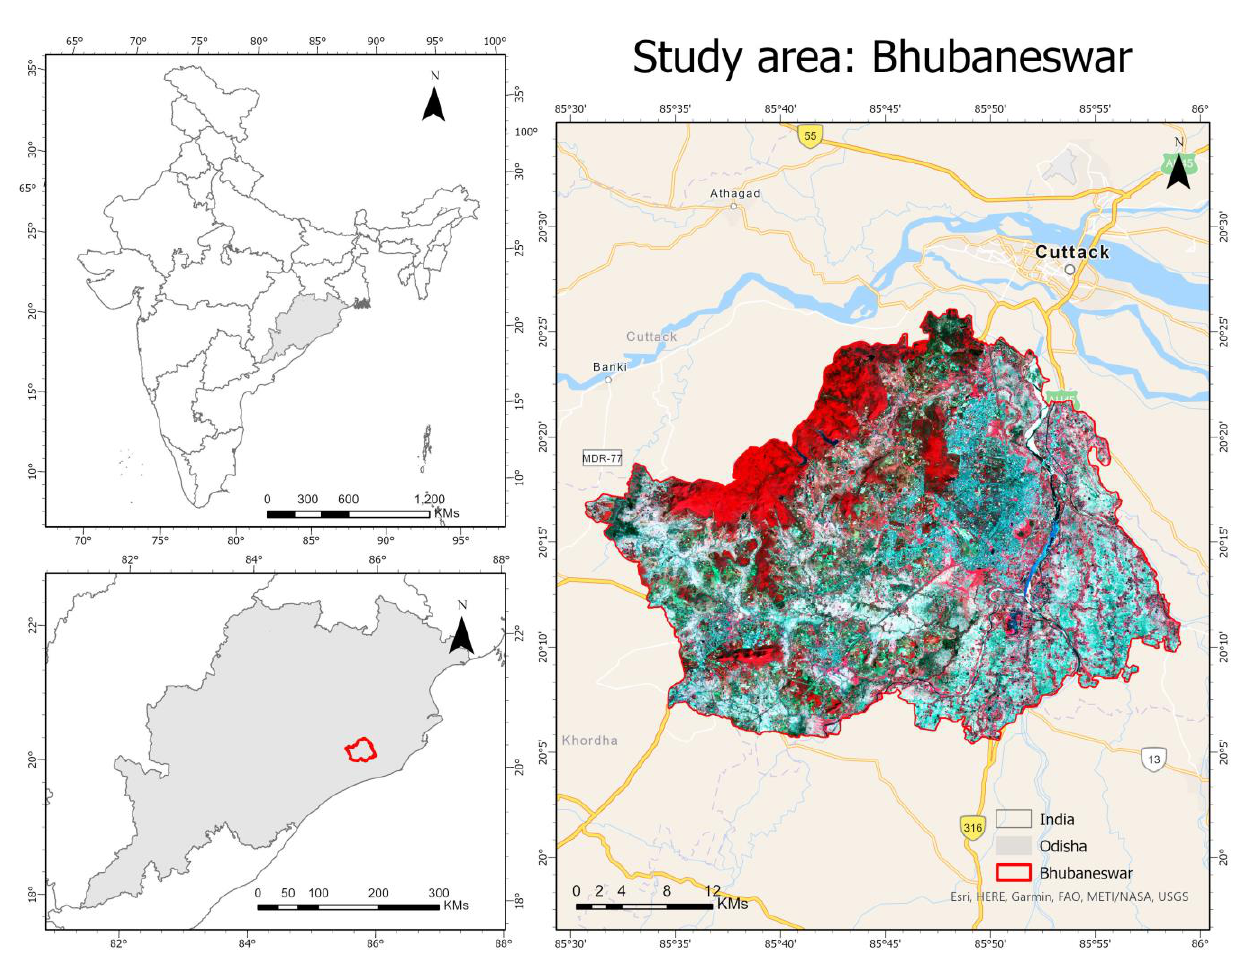
Figure 1. Location map of the study